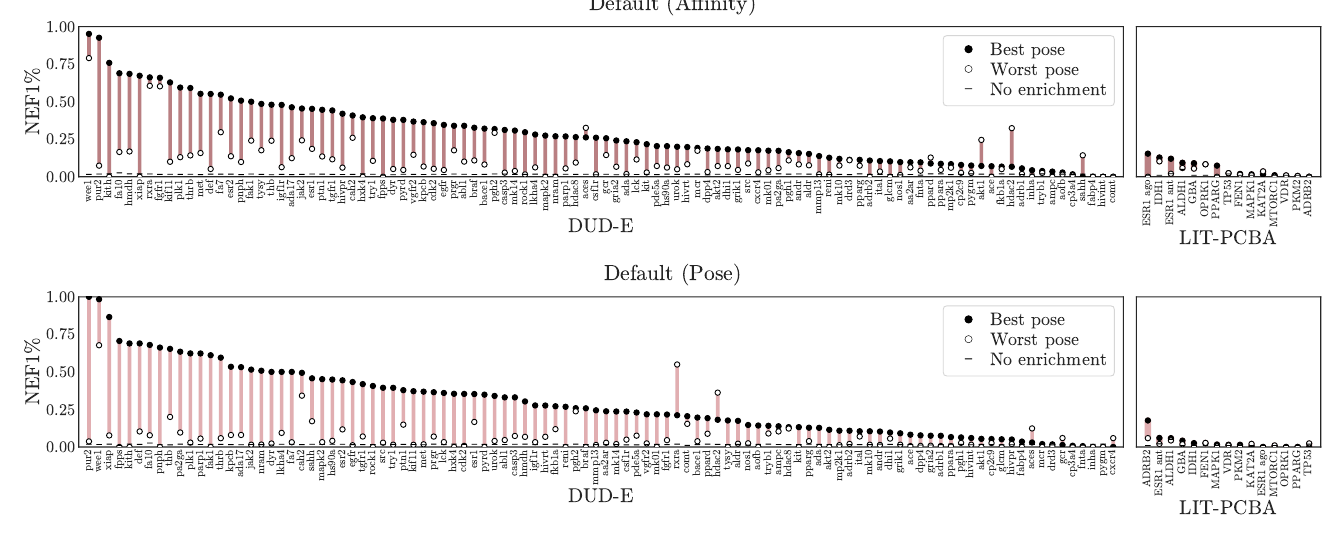
Figure 5. Pose sensitivity assessment. For each target the NEF1% achieved using the best scoring pose is contrasted with the NEF1% achieved using the worst scoring pose using the Default ensemble to score. Additional models and metrics are shown in Figures S20 and S21. The x -axes are sorted independently by the NEF1% of the best scoring